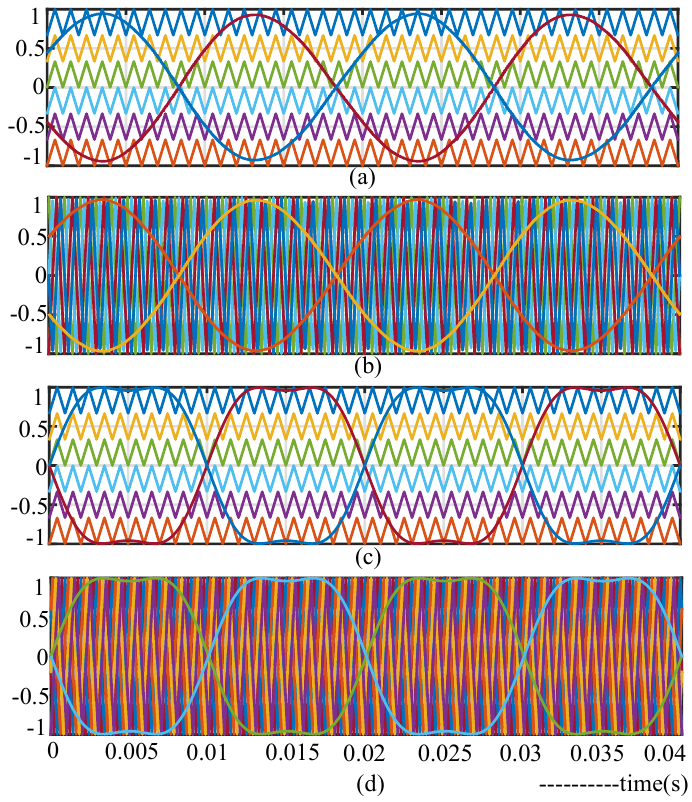
Figure 9. Modulation schemes conducted on this converter. ( a ) Sine PWM with level-shifted carrier (SPWMLSC); ( b ) Sine PWM with phase-shifted carrier (SPWMPSC); ( c ) Sine with third harmonic injected level-shifted carrier (STHILSC); and ( d ) Sine with third harmonic injected phase-shifted carrier (STHIPSC).